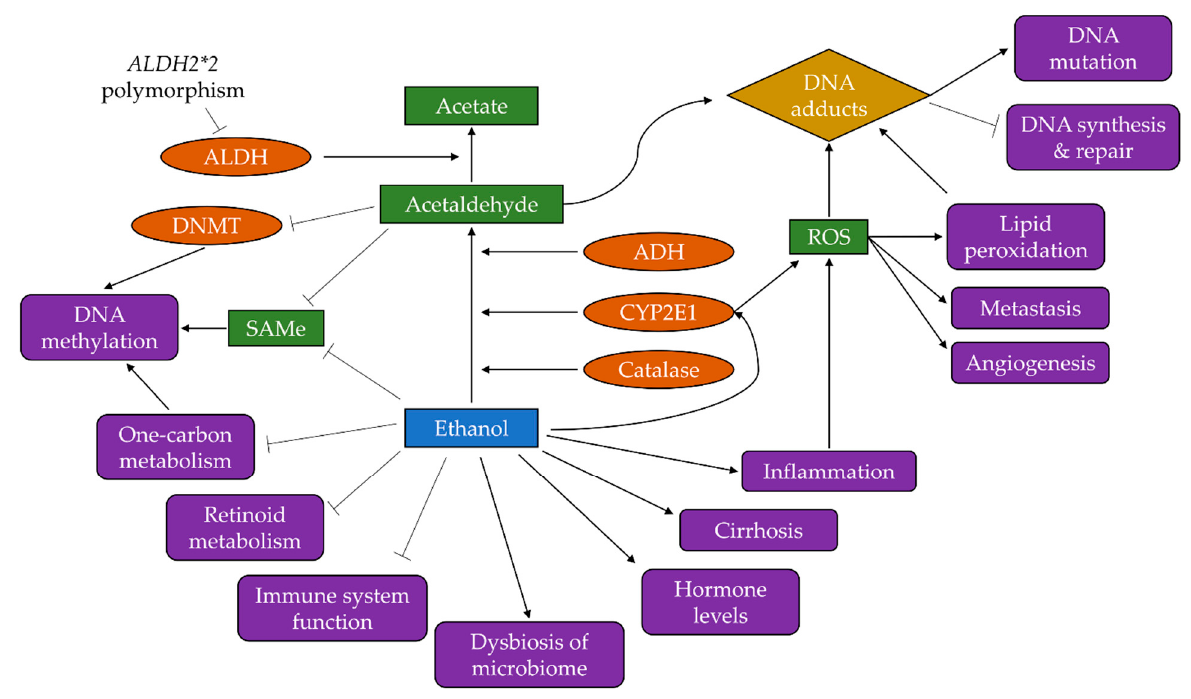
Figure 4. A simplification of the pathways by which alcohol, as ethanol, might drive carcinogenesis. The enzymes alcohol dehydrogenase (ADH), cytochrome P-450 2E1 (CYP2E1), and catalase metabolise ethanol to acetaldehyde; acetaldehyde dehydrogenase (ALDH) enzymes then metabolise acetaldehyde to acetate but common polymorphisms can reduce ALDH activity. Acetaldehyde forms DNA adducts causing mutations and blocking DNA synthesis and repair. Both ethanol and acetaldehyde can disrupt DNA methylation by inhibiting S-adenosyl-L-methionine (SAMe) synthesis and DNA methyltransferase (DNMT) activity, and ethanol can impair one-carbon metabolism. Cytochrome P-450 2E1 (CYP2E1) activity produces reactive oxygen species (ROS) leading to lipid peroxidation, metastasis, angiogenesis, and further formation of DNA adducts. Ethanol can also induce inflammation leading to production of ROS and their downstream effects. Retinoid metabolism and the normal function of the immune system are both impaired by ethanol, while ethanol may lead to increases in sex hormone levels, as well as dysbiosis of the microbiome and liver cirrhosis.